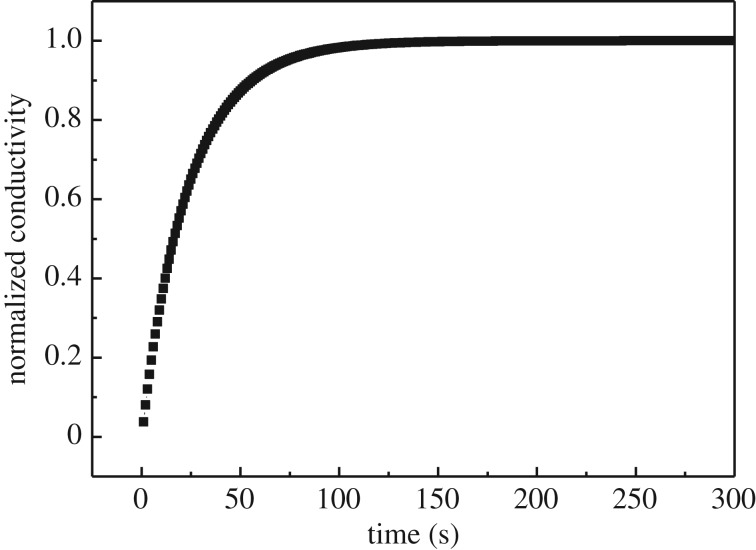
Normalized conductivity versus time at 800°C upon a step change of PO2 from 0.05 bar to 0.21 bar for the La2NiO4 cathode in the presence of Cr2O3.